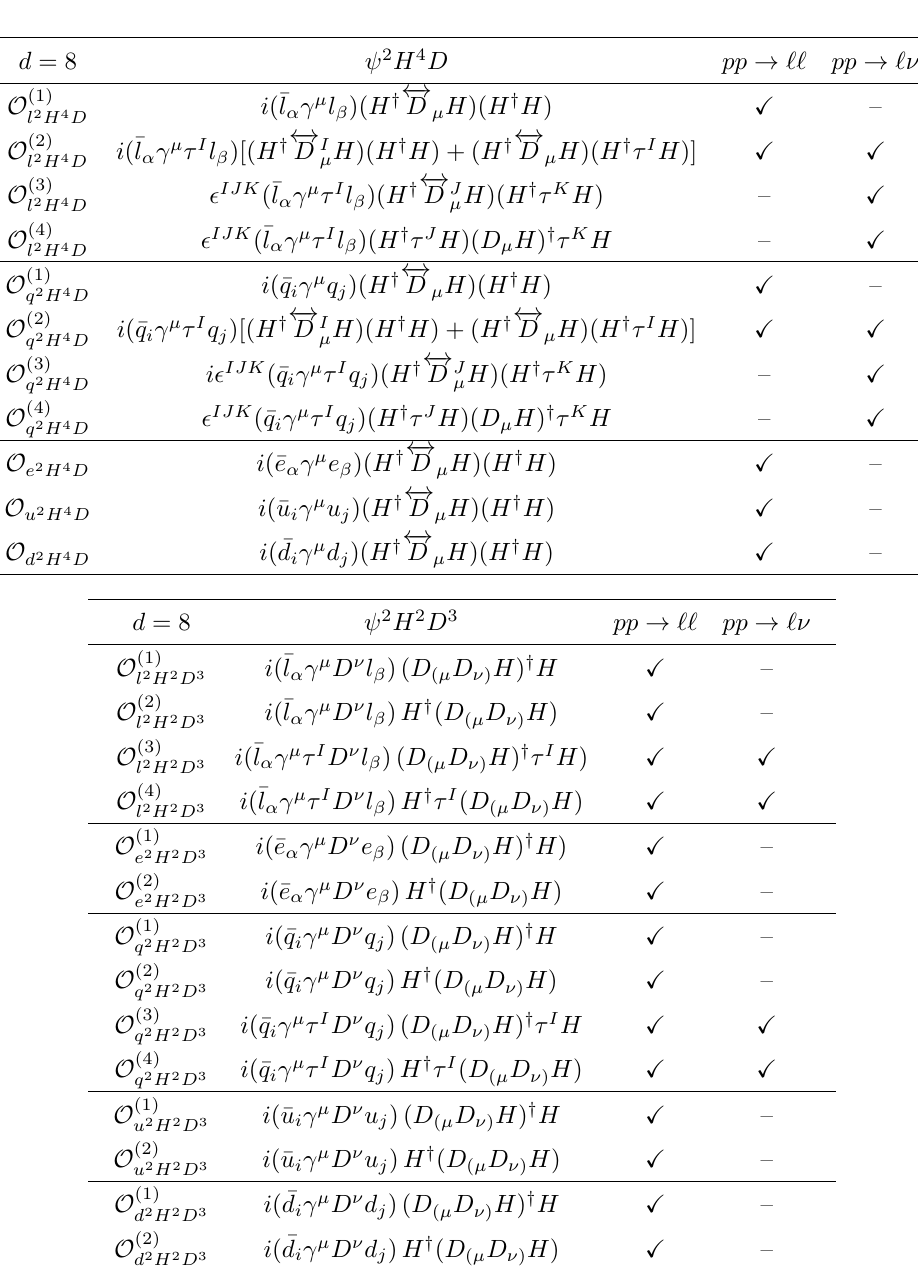
Table 8. SMEFT d = 8 two-fermion operators, in the basis of ref. [70], that contribute to the processes pp → ‘‘ and pp → ‘ν